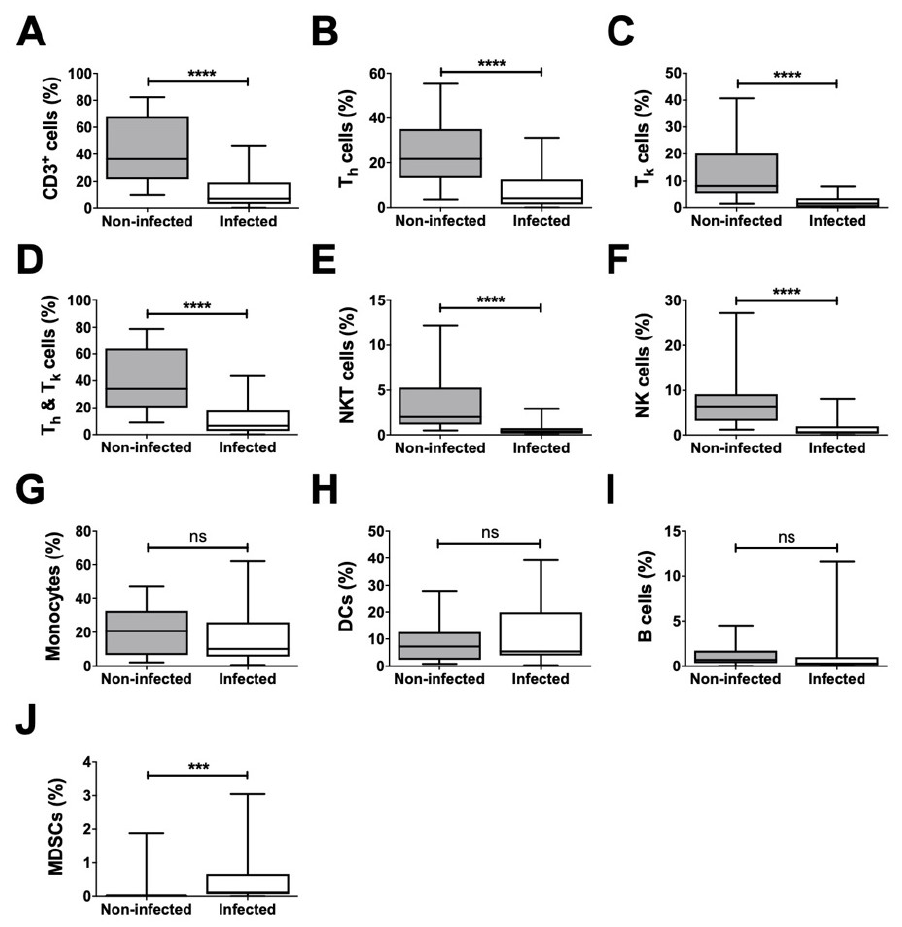
Figure 5. Detailed distribution of identified subpopulations in relation to all non-granulocytic cells. Statistical differences in ratios of the non-granulocyte cell population ( A – J ) between non-infected and infected samples; after the exclusion of granulocytes, the infected samples were found to have a significantly lower average of cell count ratios for CD3 + , T h cells, T k cells, NKT cells, and NK cells. Only the proportion of MDSCs was increased in infected synovial fluid relative to that in non-infected samples. *** p < 0.001, **** p < 0.0001, ns: non-significant.